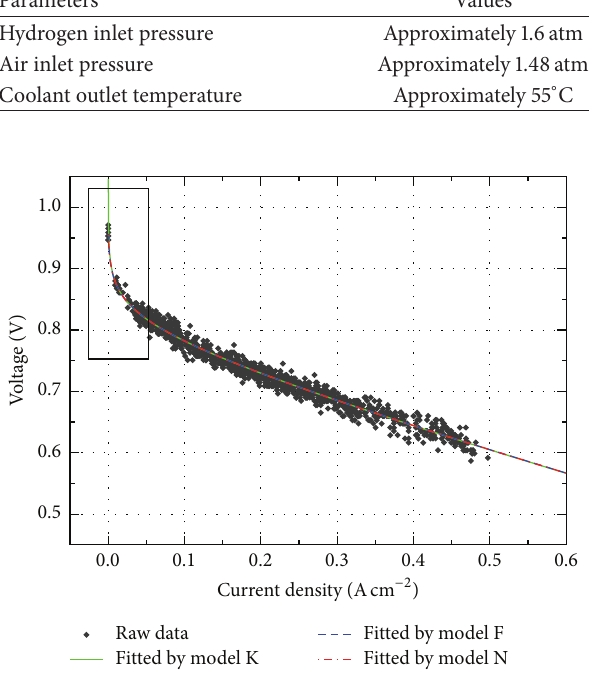
Figure 7: Comparison of measured and fitted polarization curves (road